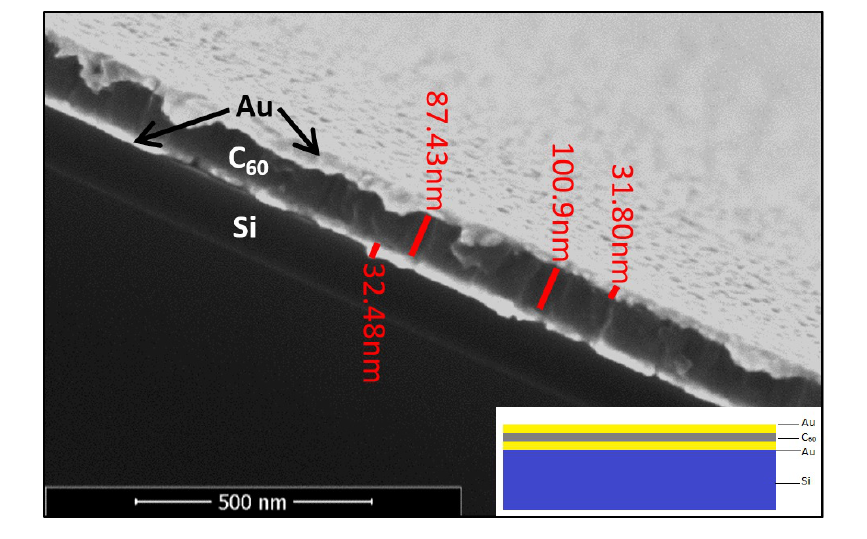
Figure 1. HR-SEM micrograph of C 60 in Au micro cavity, inset schematic cross-section of the